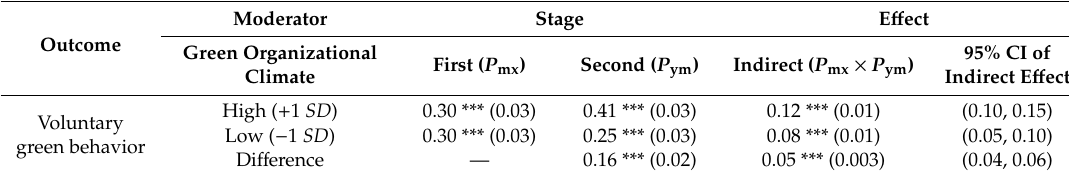
Table 4. First-stage, second-stage, and conditional indirect effect results.